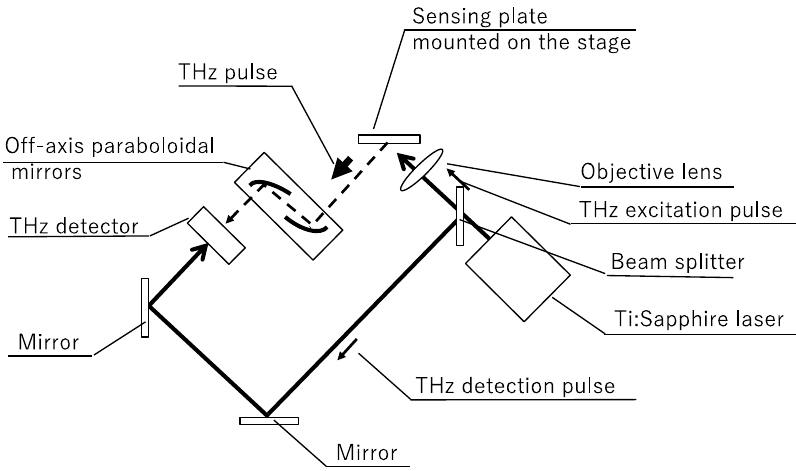
Figure 4. Schematic of the optical setup of the TCM.